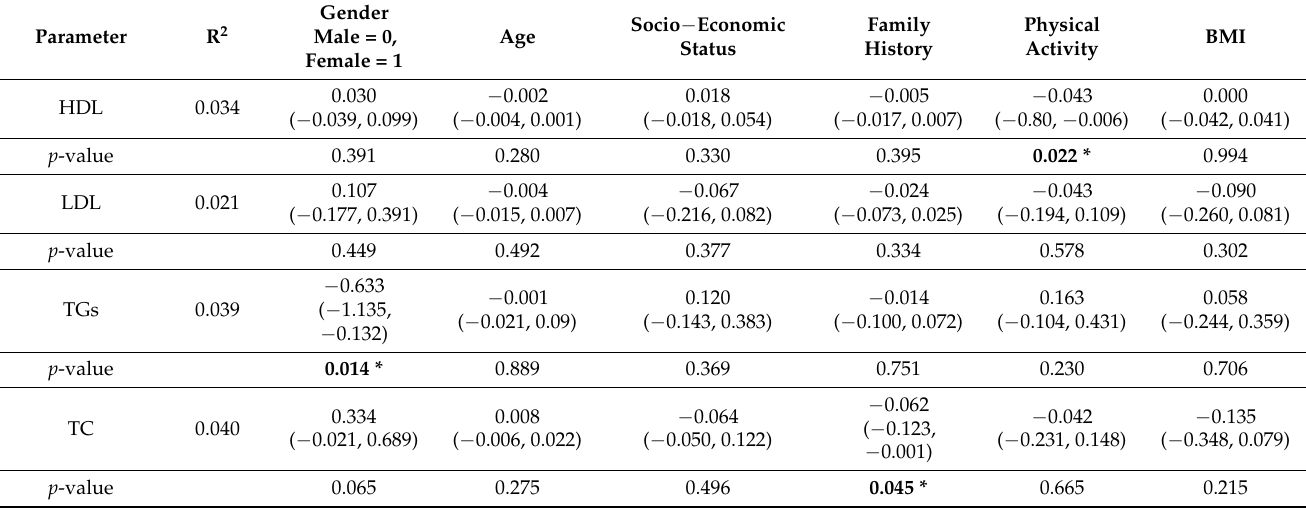
Table 2. Linear Regression Analysis for Predictors of